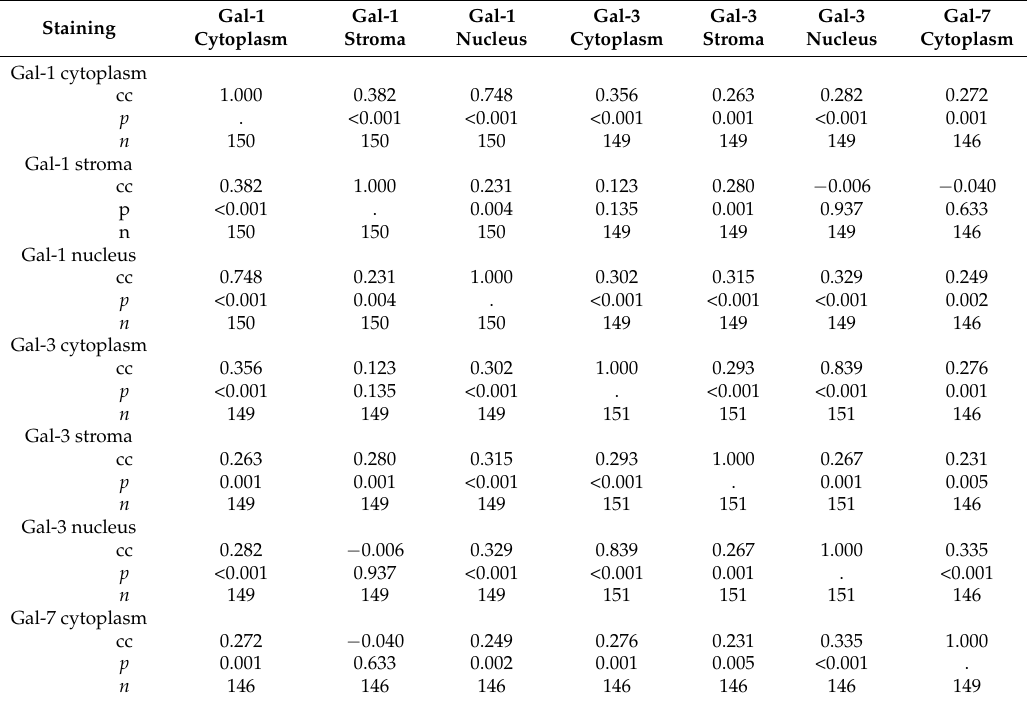
Table 5. Correlation